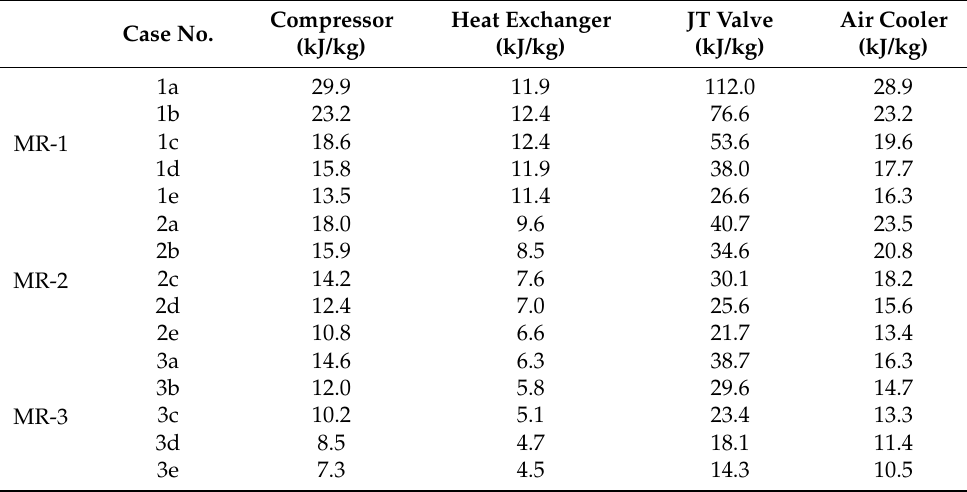
Table 7. Exergy loss of individual equipment of proposed NG pre-cooling cycle. Case No.